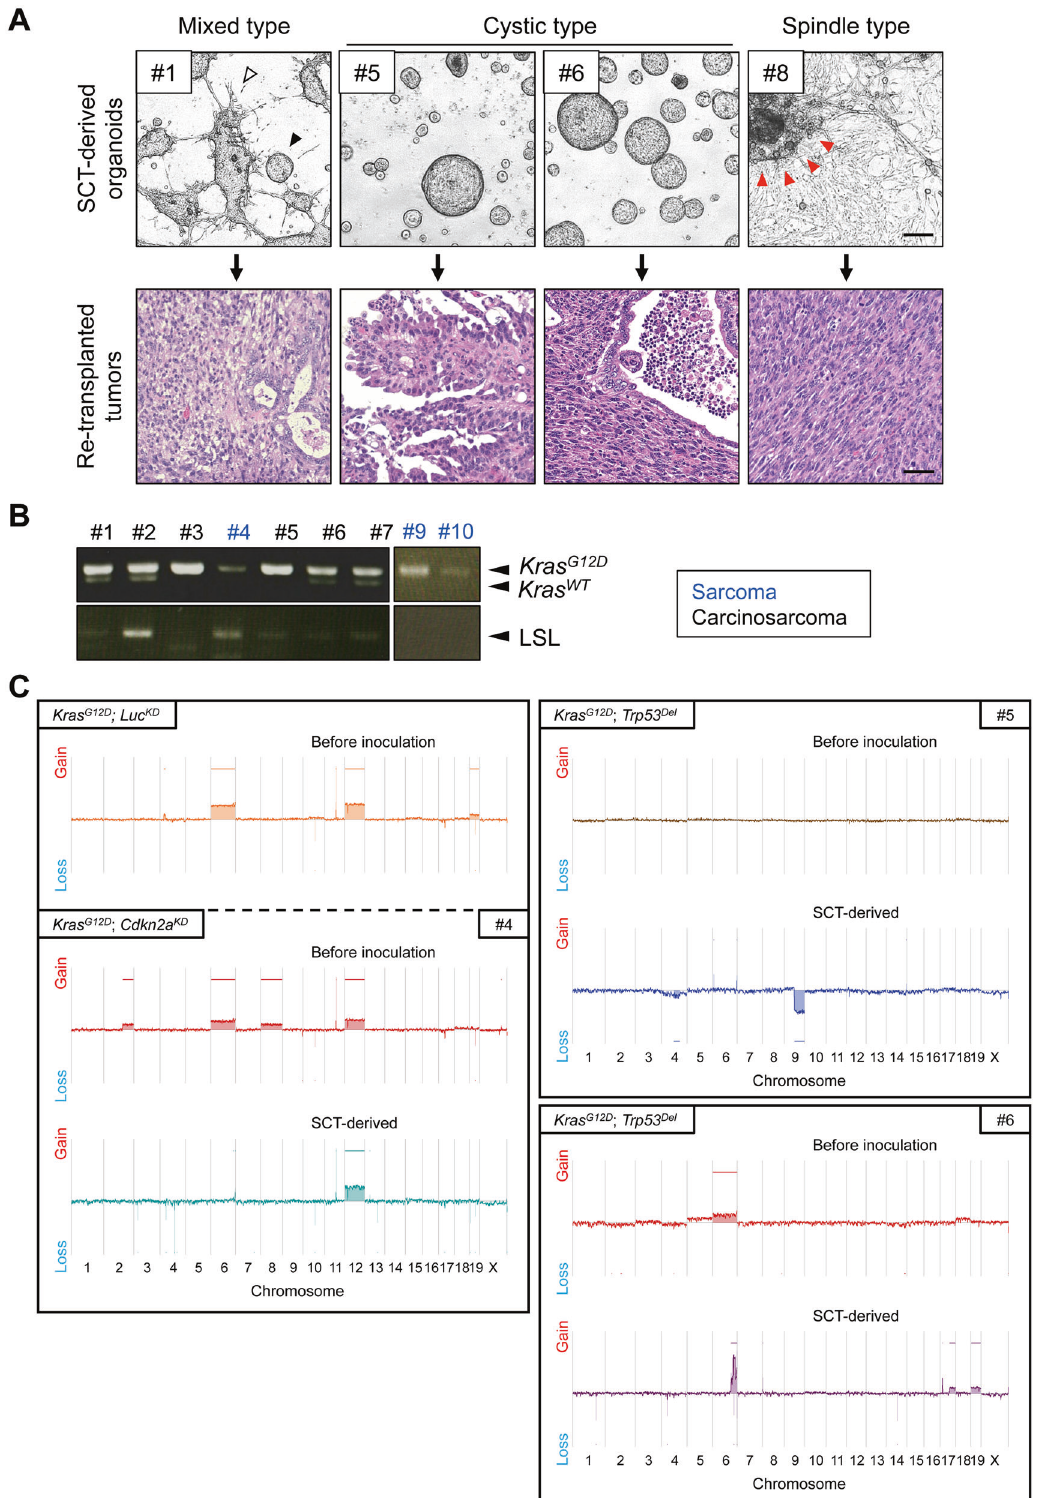
Fig. 5 Morphological and genomic heterogeneity among tumor-derived organoids. A Morphological classi fi cation of organoids recovered from subcutaneous tumors. Upper panel , mixed type (#1) contained both spindle-like cells that protrude from the organoids ( white arrowhead ) and standard cystic organoids ( black arrowhead ). Cystic type (#5 and #6) contained only standard cystic organoids, whereas spindle-type (#8) contained only spindle-like cells with occasional cell aggregation ( red arrow heads ). Scale bar, 200 μ m. Lower panel , H&E staining of tumors induced by the re-inoculation of subcutaneous tumor-derived organoids. Mixed type induced the formation of carcinosarcoma (CS) (#1); cystic type, adenocarcinoma (#5), or CS (#6); and spindle-type sarcoma (#8). Scale bar, 50 μ m. B Genomic PCR analysis of the Kras locus in tumor- derived organoids. C Copy number alterations in transduced or tumor-derived organoids as identi fi ed by array CGH analysis. SCT, subcutaneous tumor; Luc KD , introducing sh Luc